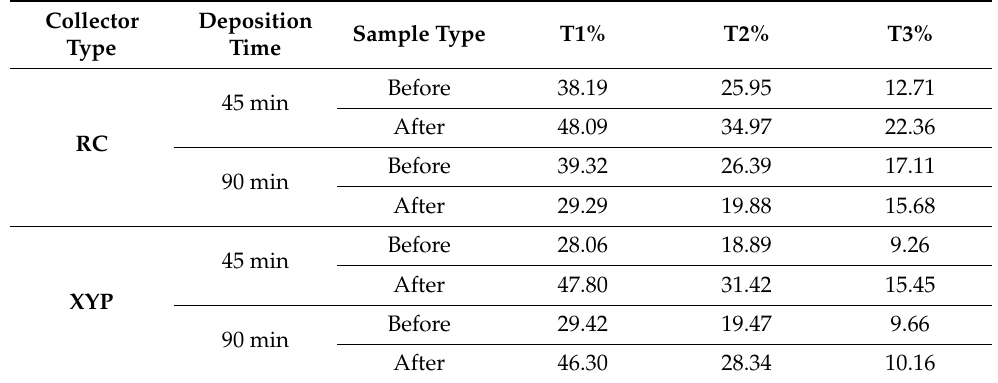
Figure 9. SEM images of the obtained XYP90 scaffolds and binary images with three thresholds before mechanical tests (top row) and after mechanical tests (bottom row). T1–T3: threshold 1–3. Table 5. Porosity measurements of binary images of different samples with various thresholds before and after mechanical